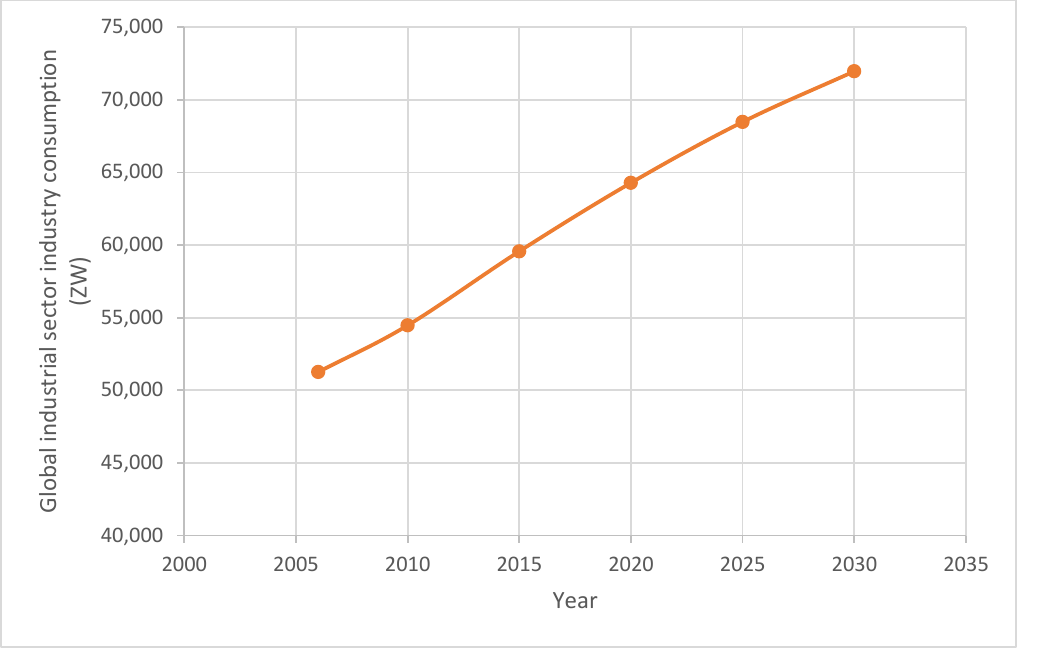
Figure 2. Global projections for industrial sector consumption [7] .